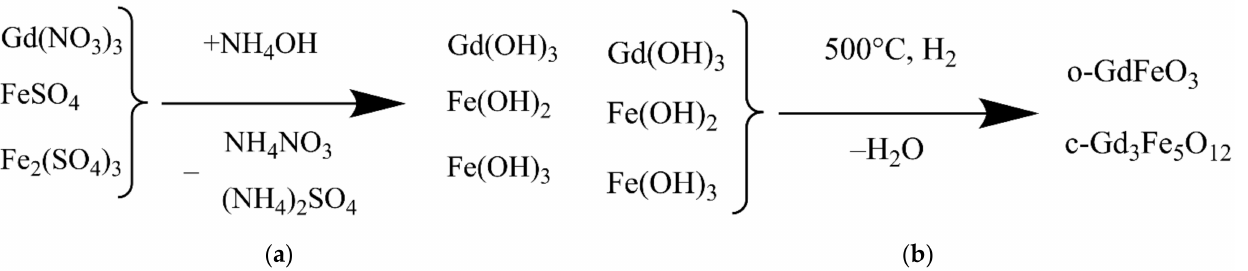
Figure 1. Synthesis scheme: ( a ) deposition of a mixture of hydroxides; ( b ) Synthesis of gadolinium ferrate and trigadolinium pentairon(III) oxide during